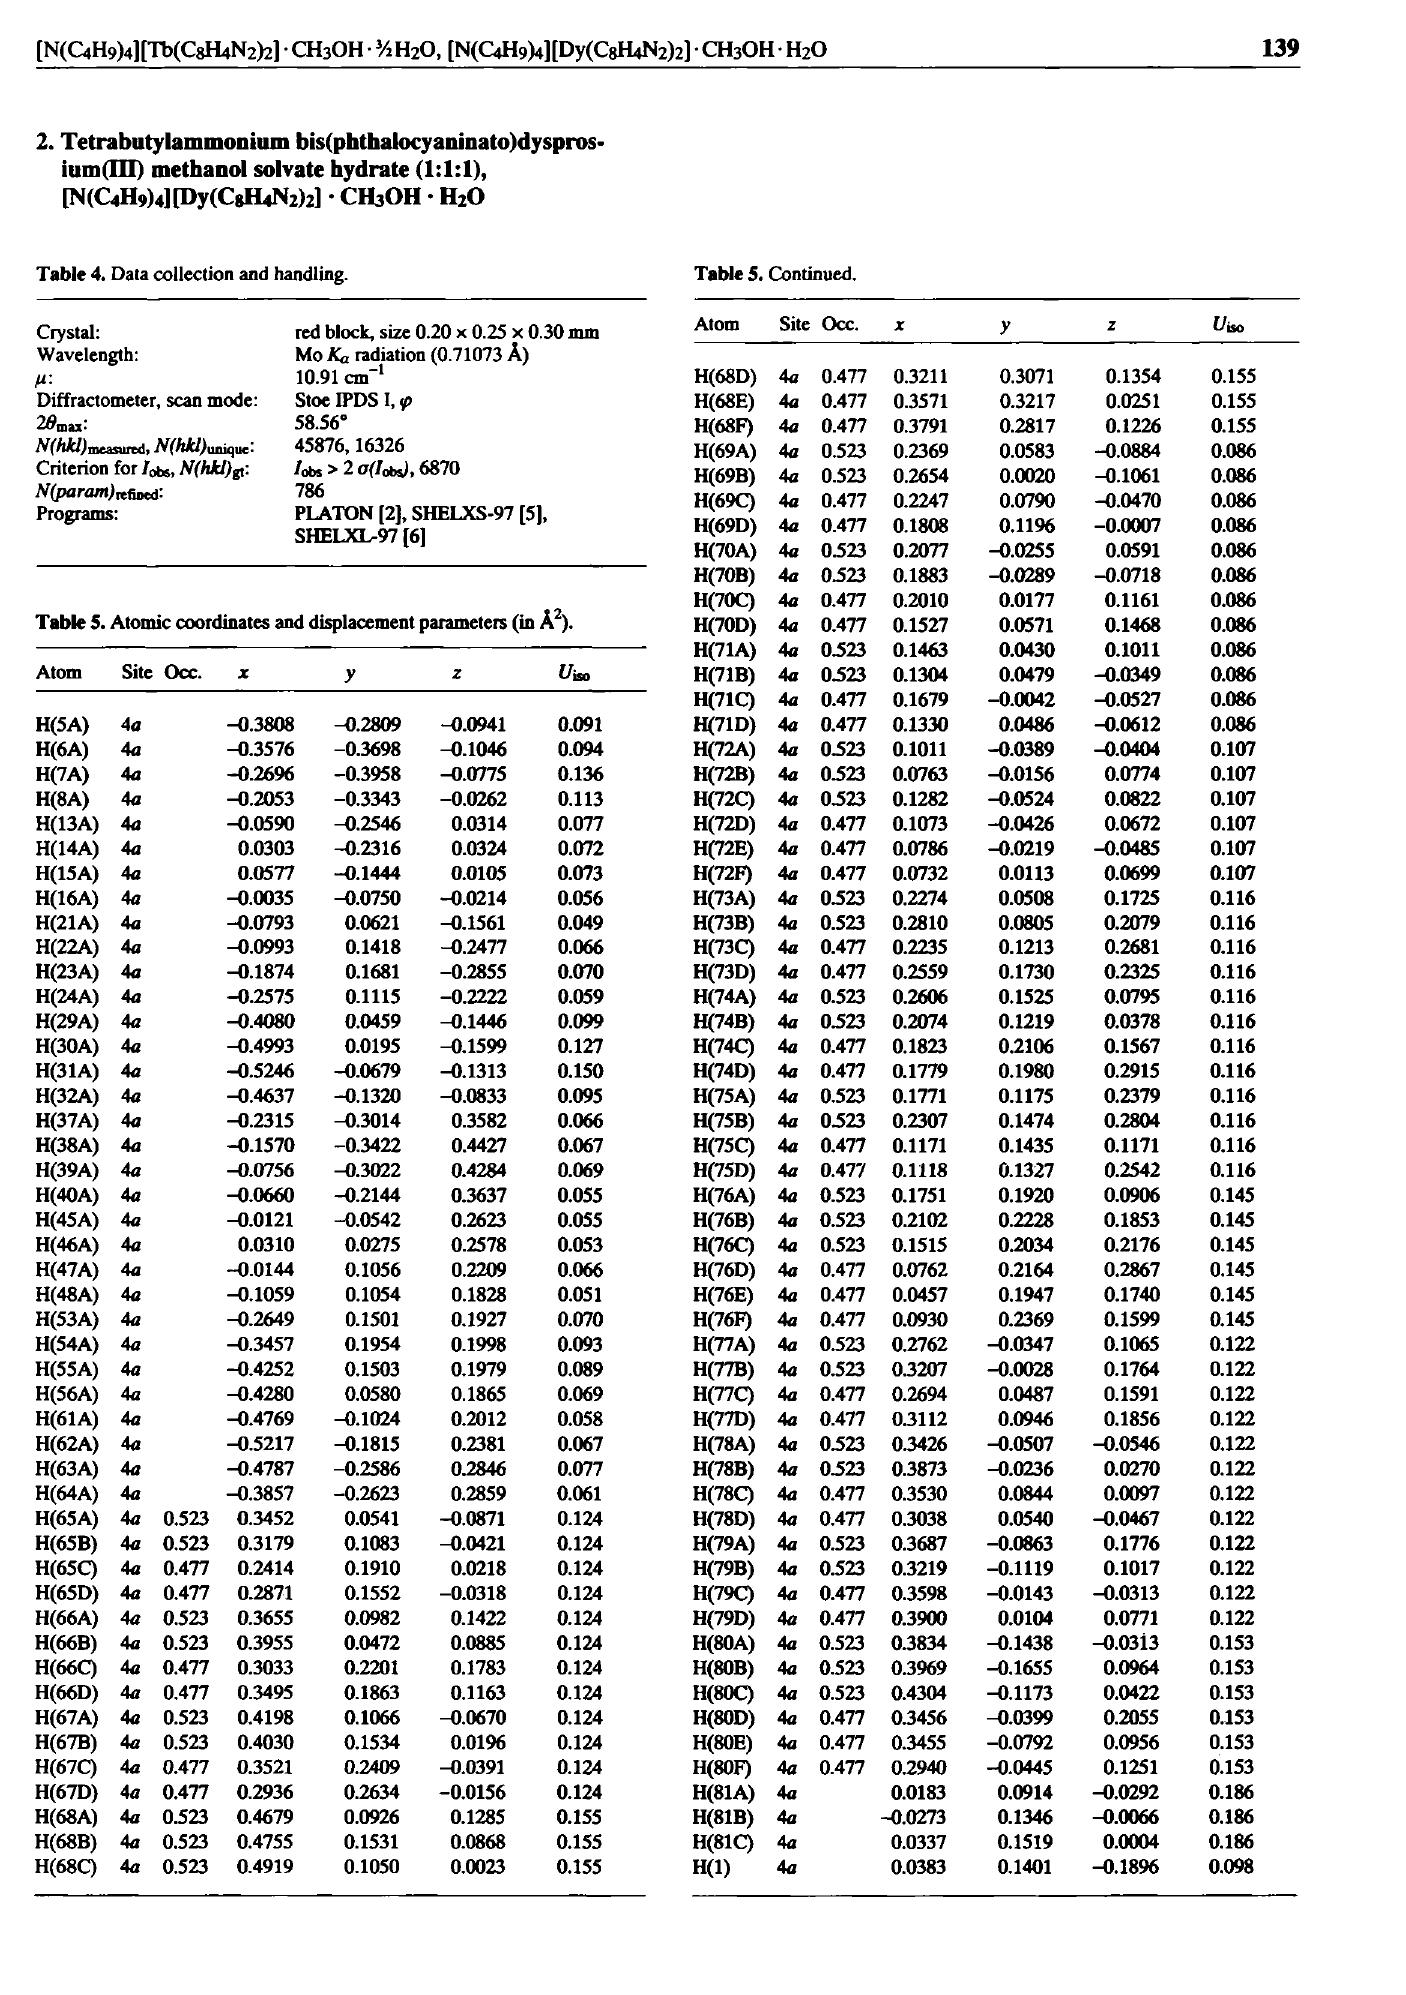
Table 4. Data collection and handling.